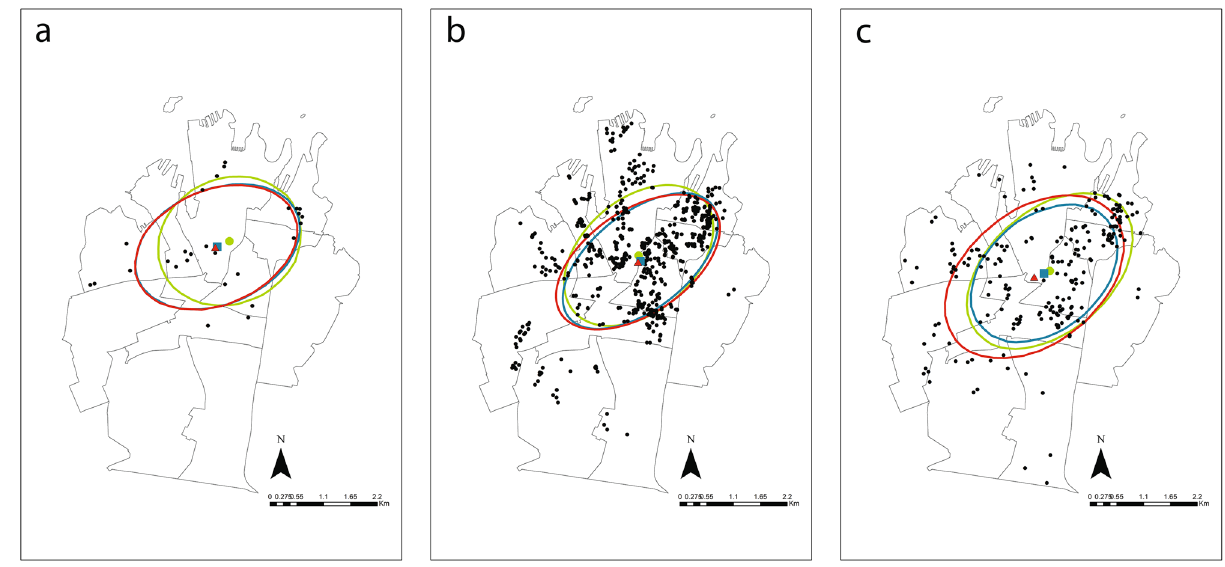
Figure 4. Distribution of trapping success ( a ), rodent bait stations visitation ( b ) and residents’ rodent complaints ( c ) within the Council of the City of Sydney and their mean centers and associated directional ellipses during pre-lockdown ( ), lockdown ( ) and post-lockdown ( ) periods. Maps generated using ArcGIS Desktop v10.5 88